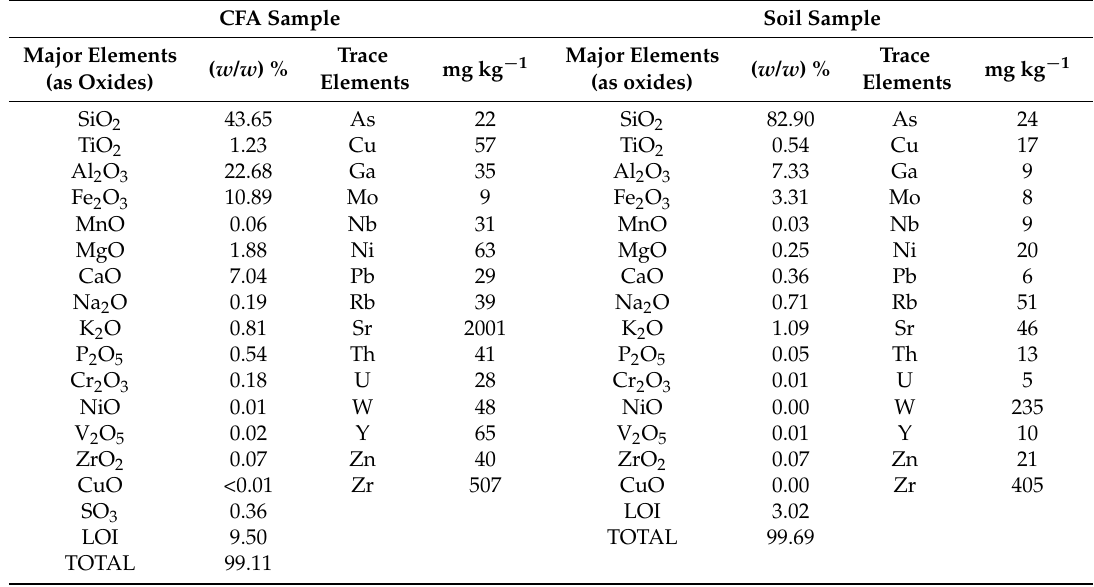
Table 1. Comparison of the chemical composition of CFA and soil samples.